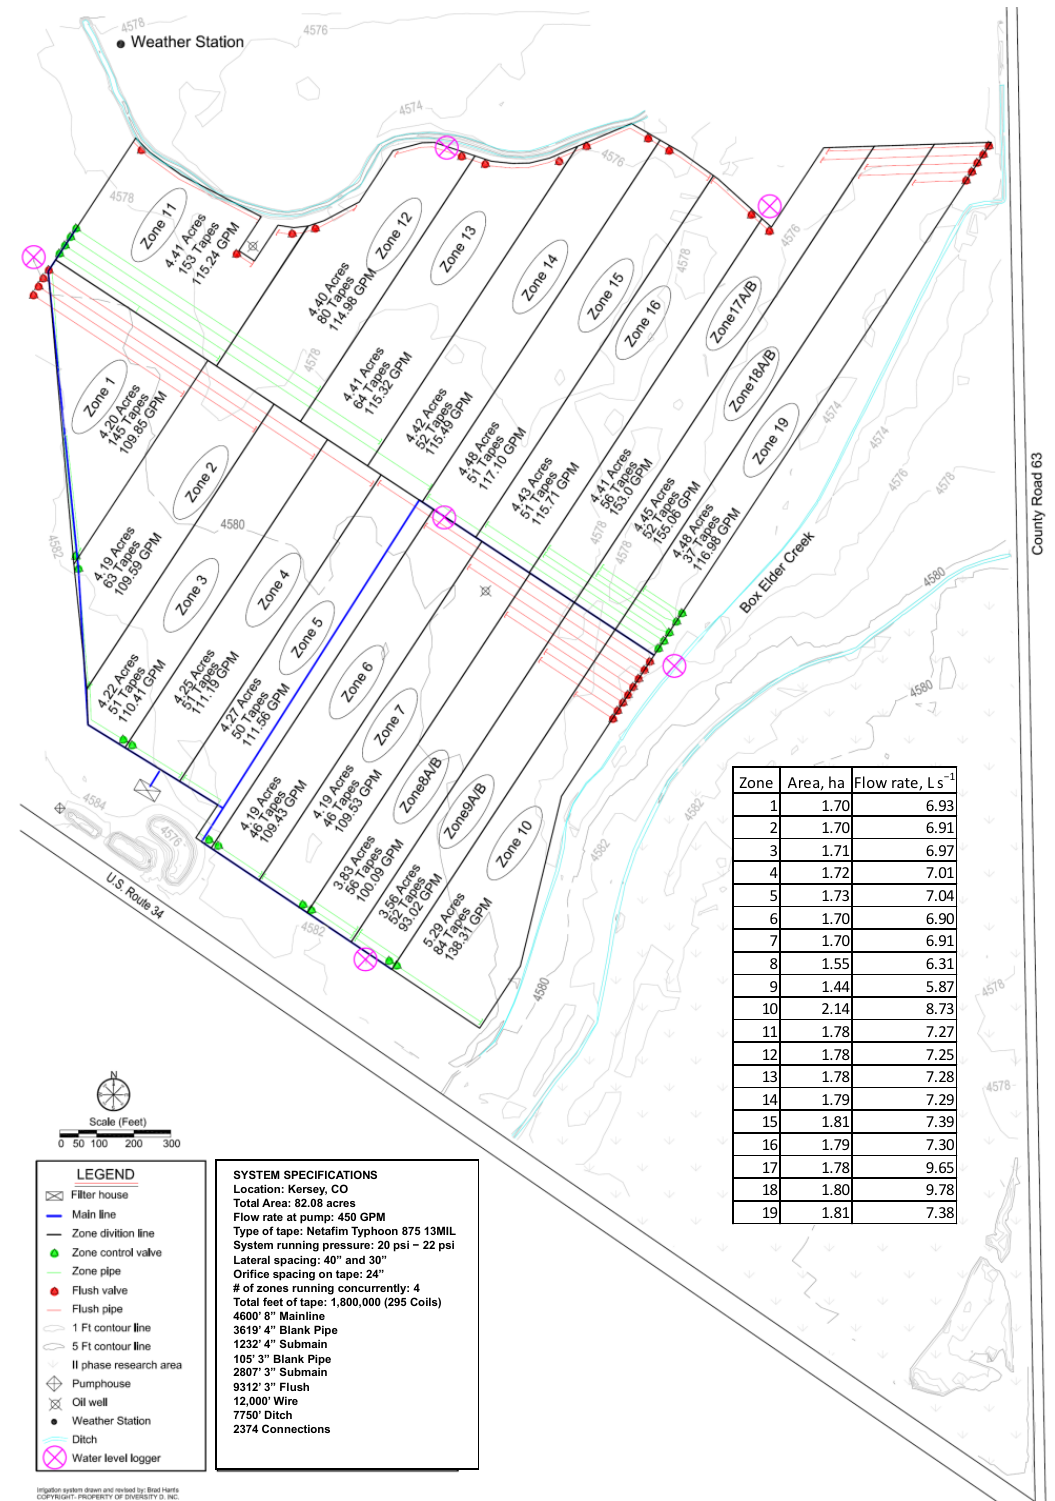
Figure 1. SIEP site map of the observational field zones and irrigation system specifications. Zone specifications were provided by the SSDI designer in USA customary units (acres and GPM), and equivalent metric units for area and flow rate are given in the table at the right of the zone map.